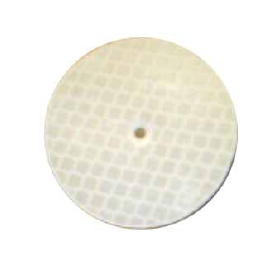
 Geometric figure : this shows the difference between the coordinates of the targets measured by scanner and the total station  Intensity figure : this shows the amount of reflected intensity from the targets which is measured by the scanner. The intensity value ranges between 0 and 1  Density figure : this figure is an indication on the number of reflected points that are received and measured by the scanner